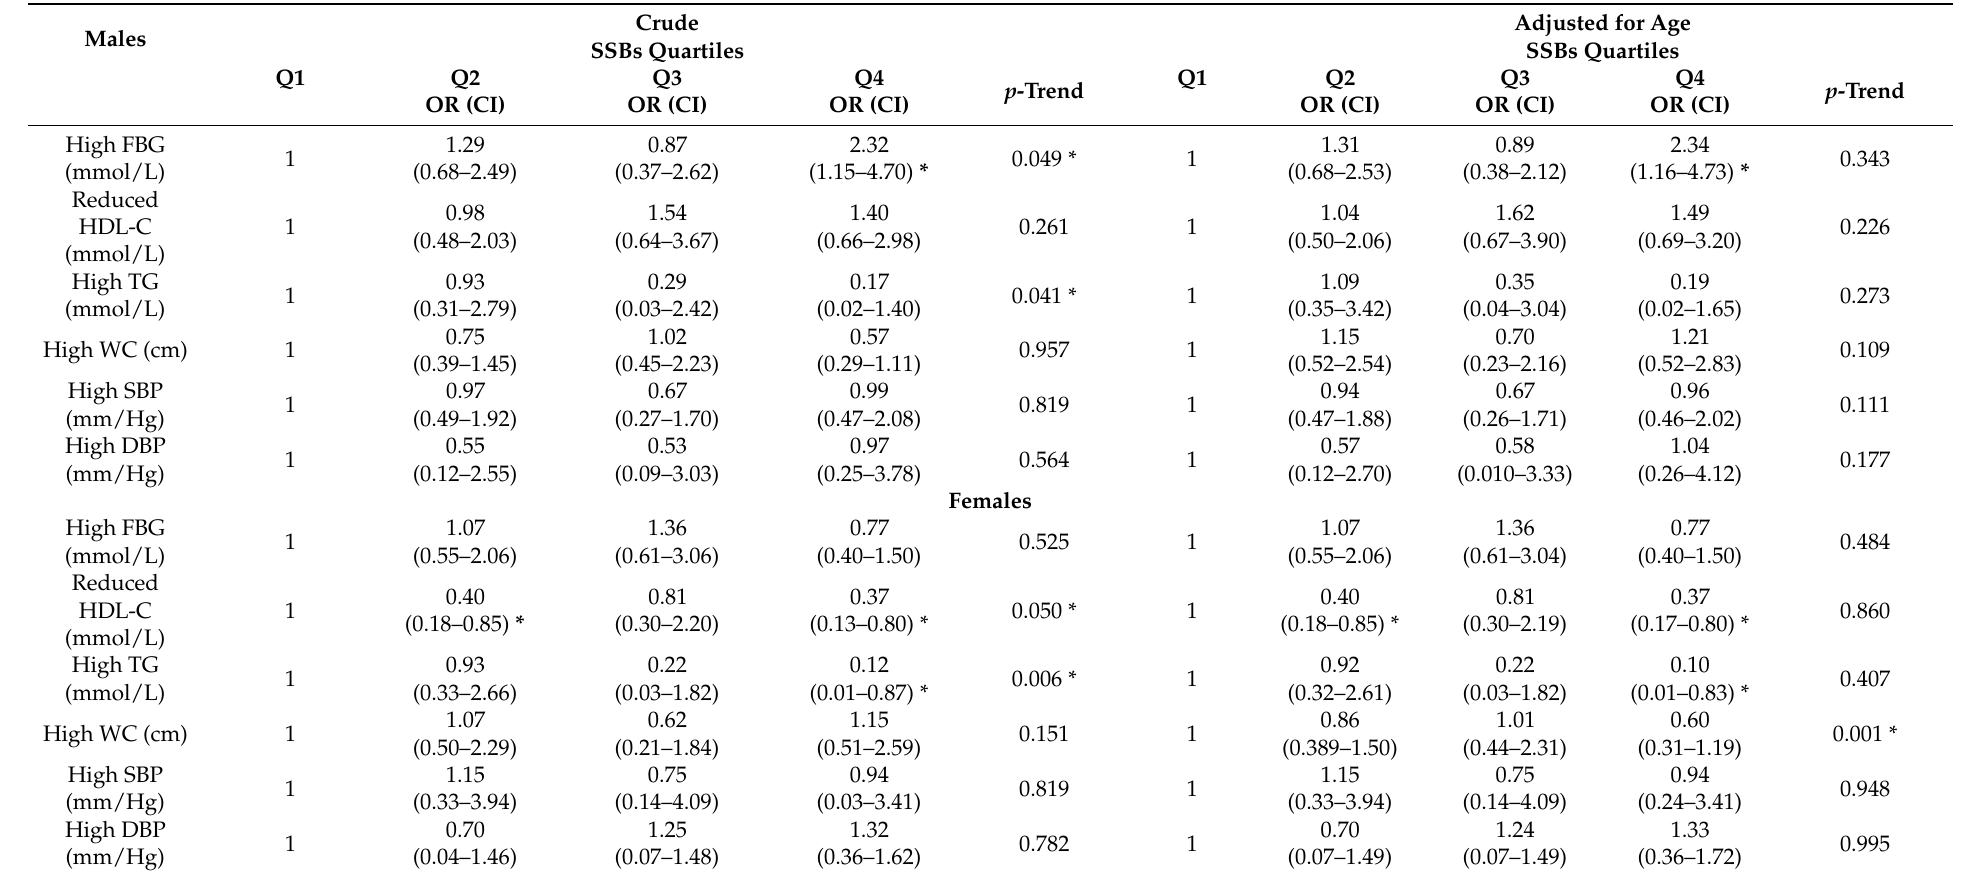
Table 3. The odds ratios and 95% confidence interval for MetS components with SSBs quartile among Ellisras young rural adults aged 22–30